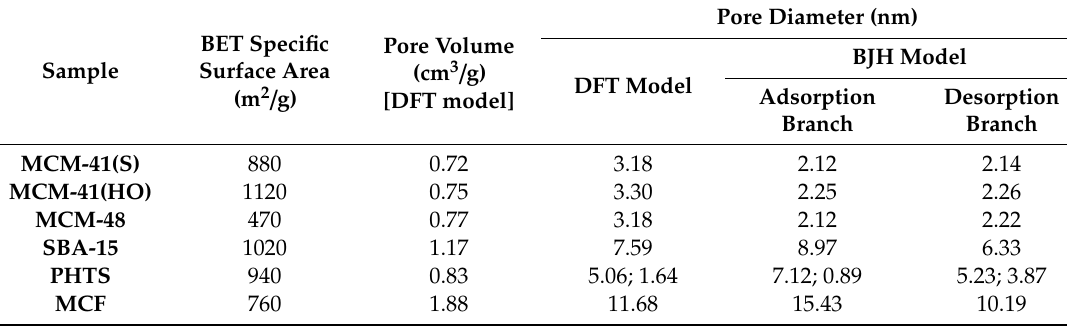
Figure 4. Schematic representation of the pore structure: SBA-15 and PHTS. Table 3. Calcined MSN samples evaluated via N 2